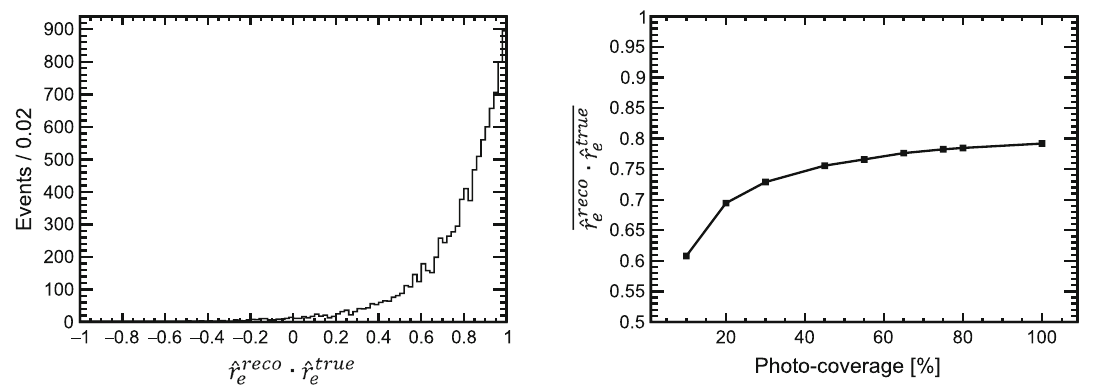
Fig. 4 Simulation of a liquid scintillator detector similar to KamLAND-Zen, but equipped with 100 ps time resolution photo- detectors. Details about the simulation can be found in [39] (Left): The inner product between the reconstructed direction and the true elec-